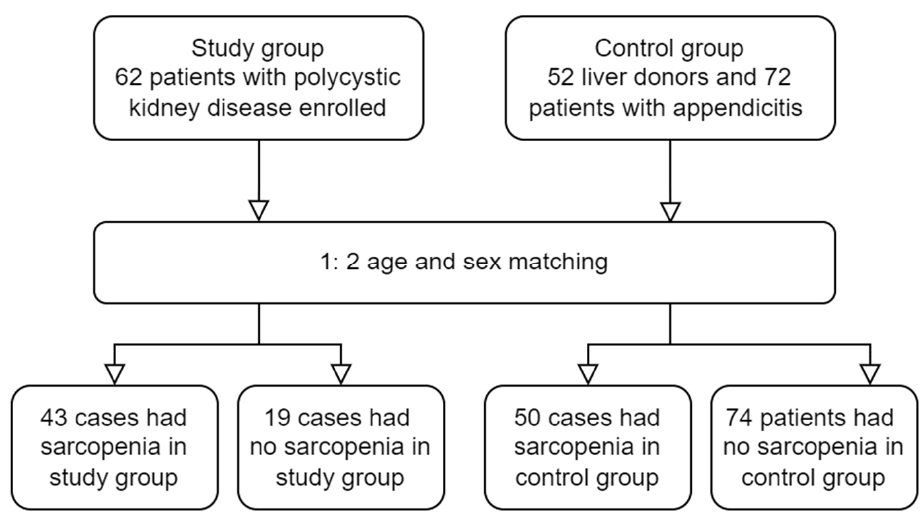
Figure 1. Flowchart of patient enrolment.